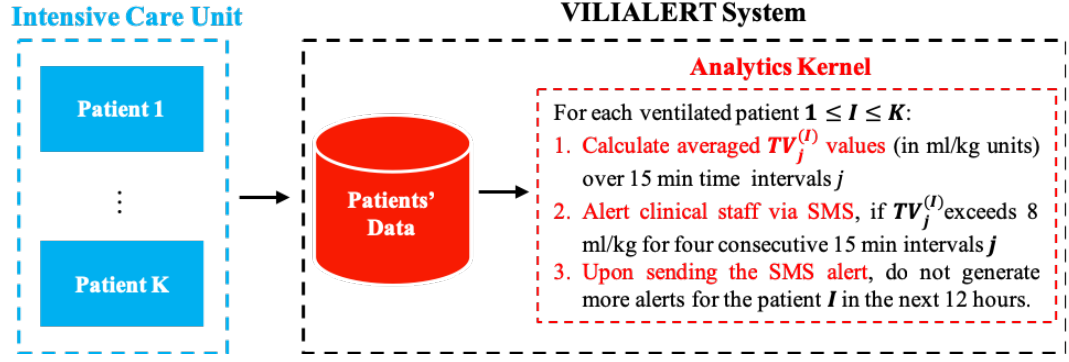
Figure 1. An architectural overview of the VILIAlert System [19]. Patient Data —patient information that is collected routinely and stored anonymously including patient ID, gender, height, and ventilator readings received at minute